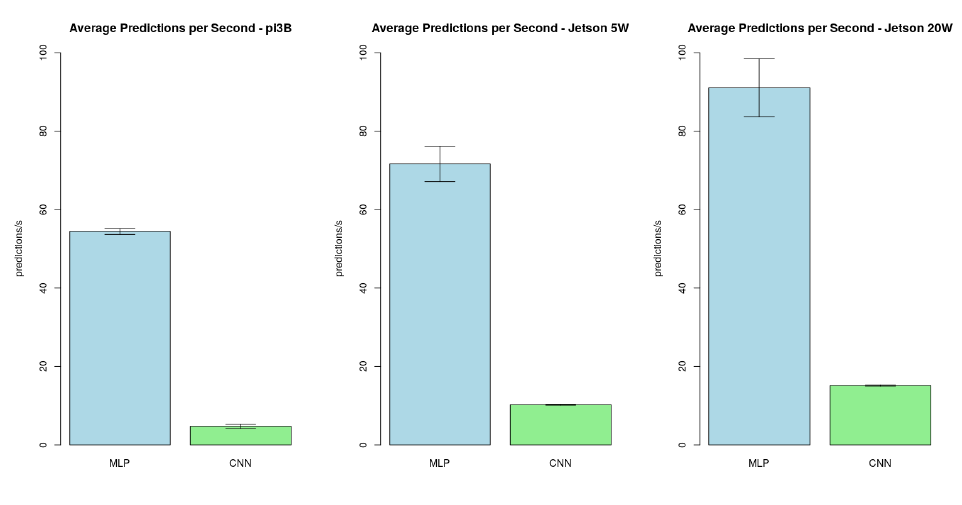
Figure 22. MLP and CNN performance comparison test results.